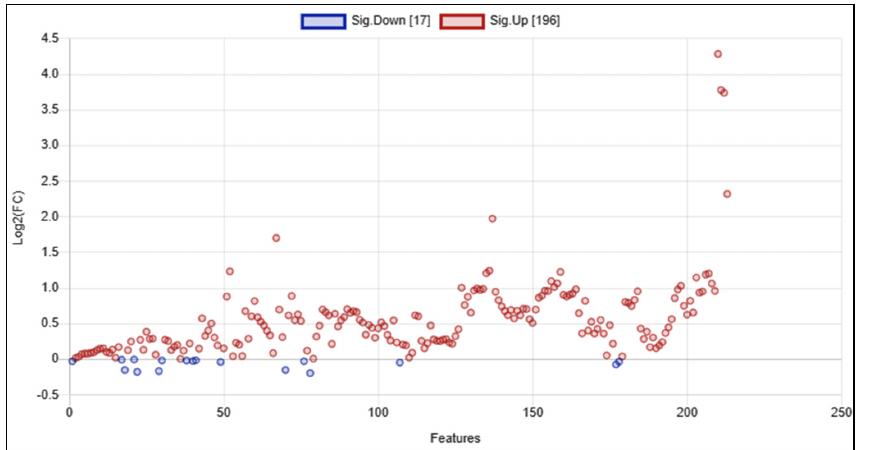
Figure 3. Significantly up- and downregulated values for univariate log 2 fold-changes computed from WMSS sample ISB buckets for the comparison of patients with an acute sore throat condition with those of an age-matched healthy control group (n = 48 participants per group, each one providing n = 5 sequential daily samples).